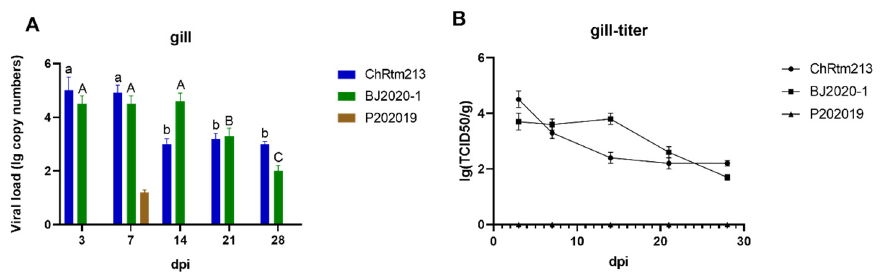
Figure 4. IPNV virus loads in gill sampled on 3, 7, 14, 21, and 28 dpi. ( A ) Replication kinetics of IPNV-infected rainbow trout. Samples were obtained in triplicate. Total RNA was extracted and analyzed by qPCR. Error bars represent the SD from triplicate within an experiment. Different letters of the same class indicated the statistical significance, p < 0.05. a, b indicated that the viral load of IPNV-ChRtm213 was significantly different at different sampling time points, p < 0.05. A, B, C indicated that the viral load of IPNV-BJ2020-1 was significantly different at different sampling time points, p < 0.05. ( B ) The detection of viral titers in the gill of IPNV-infected rainbow trout.